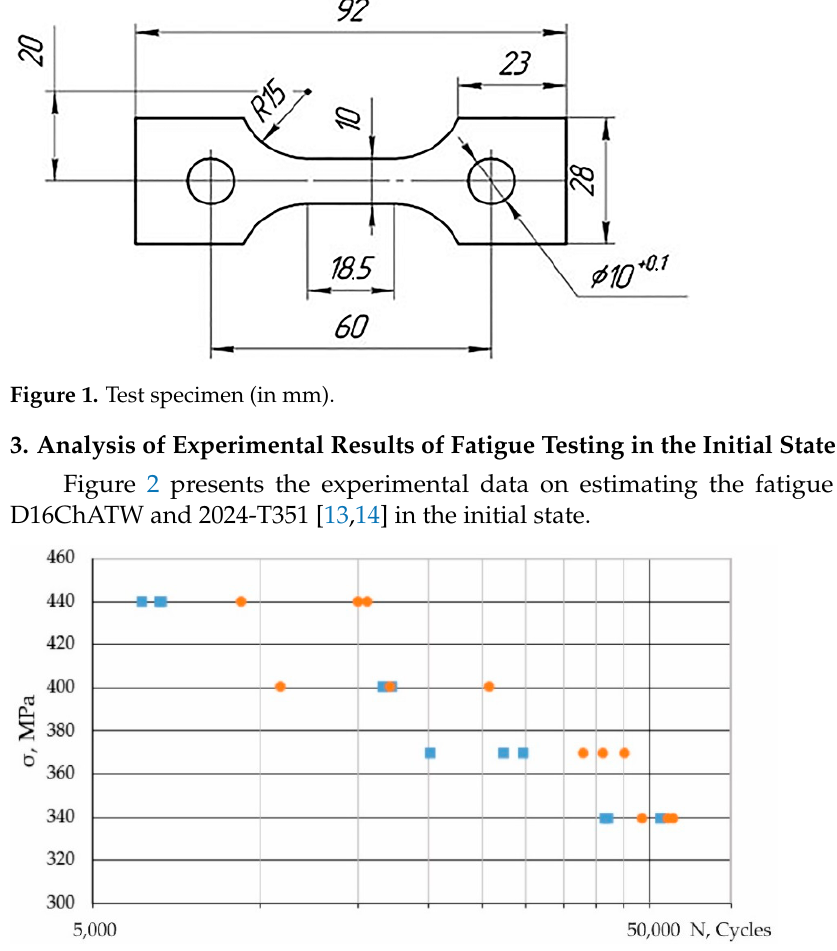
Figure 2. Fatigue testing of aluminum alloys in the initial state at variable cyclic loads: , cycles to failure (D16 ChATW ); , cycles to failure (2024- Т 351). Data from [13,14].